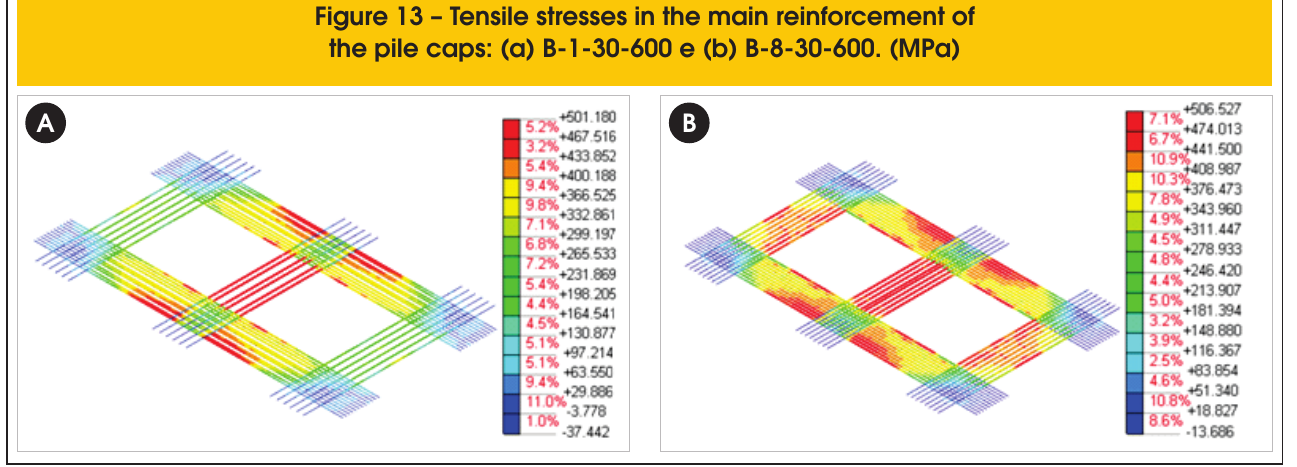
Figure 13 – Tensile stresses in the main reinforcement